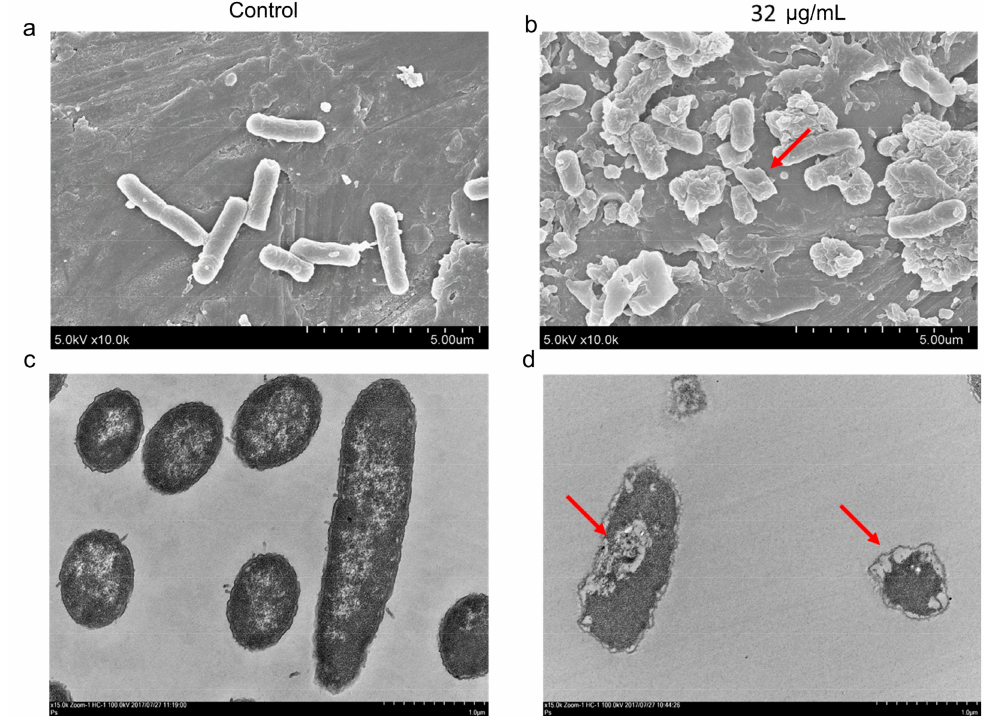
Figure 2. Electron microscopy images for AS101-treated K. pneumoniae ATCC BAA-1705. Scan- ning electron microscopy (SEM) and transmission electron microscopy (TEM) micrographs were respectively captured at 10,000 × ( a , b ), and 15,000 × magnification ( c , d ). Untreated (control) bacteria morphology remained intact and smooth ( a , c ). Leaking wrinkly surfaces (red arrows in ( b , d )) were observed following exposure to 1 × MIC (32 µ g/mL) AS101. See also Figure S5 for results of